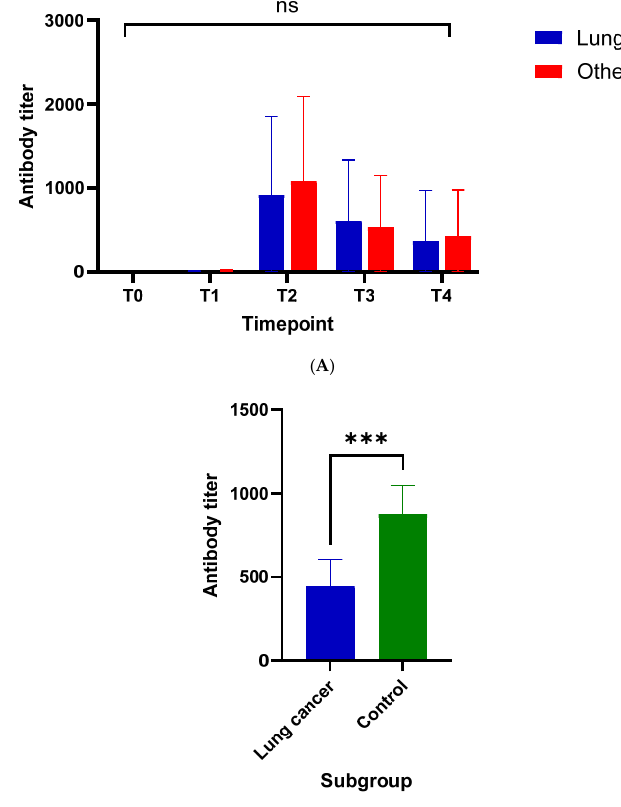
Figure A2. ( A ). Seroconversion comparison between lung and non-lung cancer patients; mean antibody titers with 95% confidence intervals (y axis) relative to timepoint assessed (x axis); ns: no statistical signif- icance; ***: statistically significant difference ( p = 0.003). ( B ). Seroconversion comparison between lung cancer patients and healthy controls; mean anti- body titers with 95% confidence intervals (y axis) relative to timepoint assessed (x axis); ns: no statistical significance; ***: statistically significant difference ( p =